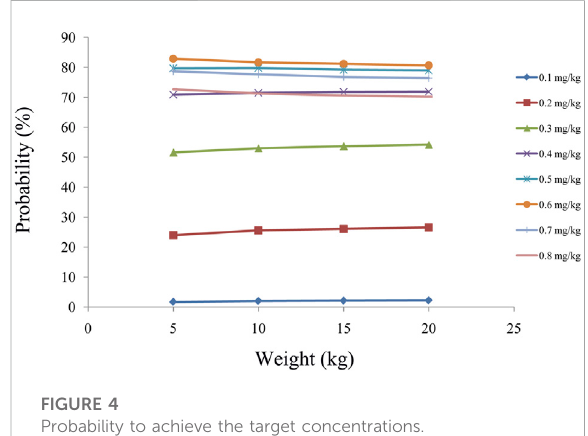
FIGURE 4 Probability to achieve the target